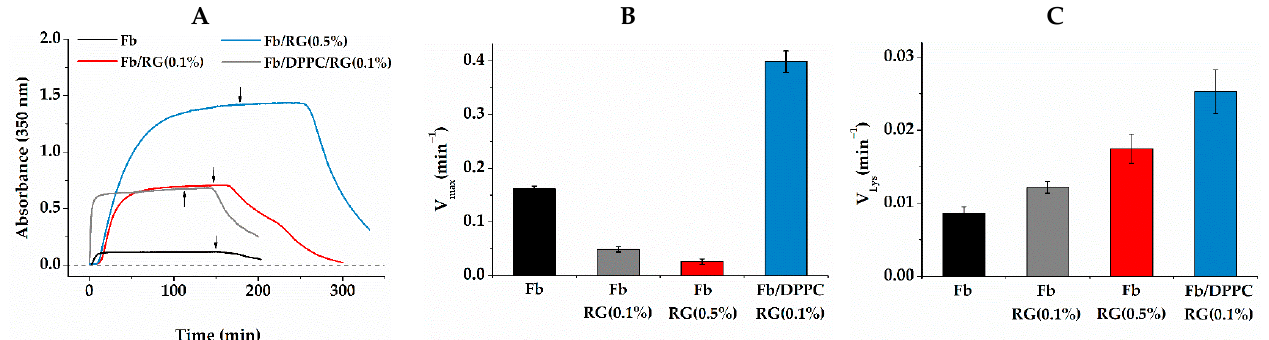
Figure 2. Kinetics of formation and lysis of fibrin ( A ) and its maximum rate of formation ( B ) and lysis ( C ) in various composite gels. RG concentration is denoted in parenthesis, Fb concentration is 1 mg/mL everywhere. The moment of trypsin introduction is marked with arrows ( A ).